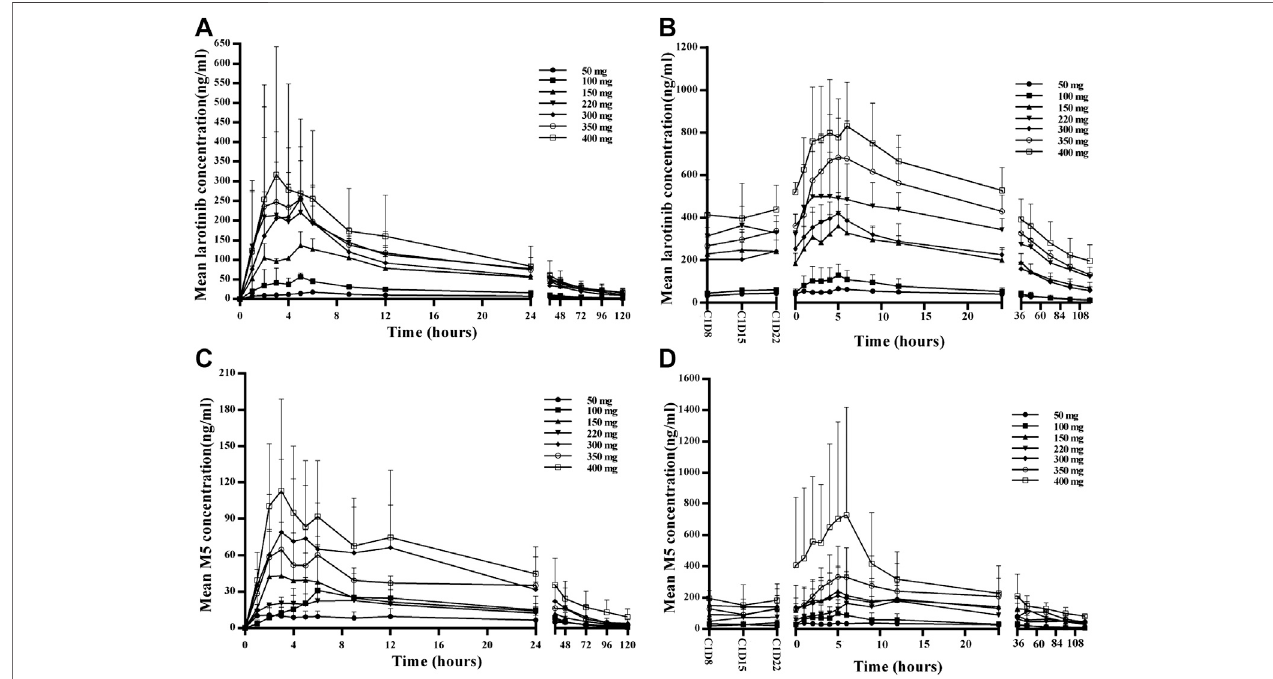
FIGURE 3 | Mean plasma concentration – time pro fi les for larotinib and M5 after administration of single and multiple doses of 50, 100, 150, 220, 300, 350 and 400 mg larotinib mesylate (A) Mean plasma concentration – time pro fi le of larotinib after a single dose; (B) mean plasma concentration – time pro fi le of larotinib after multiple doses; (C) mean plasma concentration – time pro fi le of M5 after a single dose; (D) mean plasma concentration – time pro fi le of M5 after multiple doses.